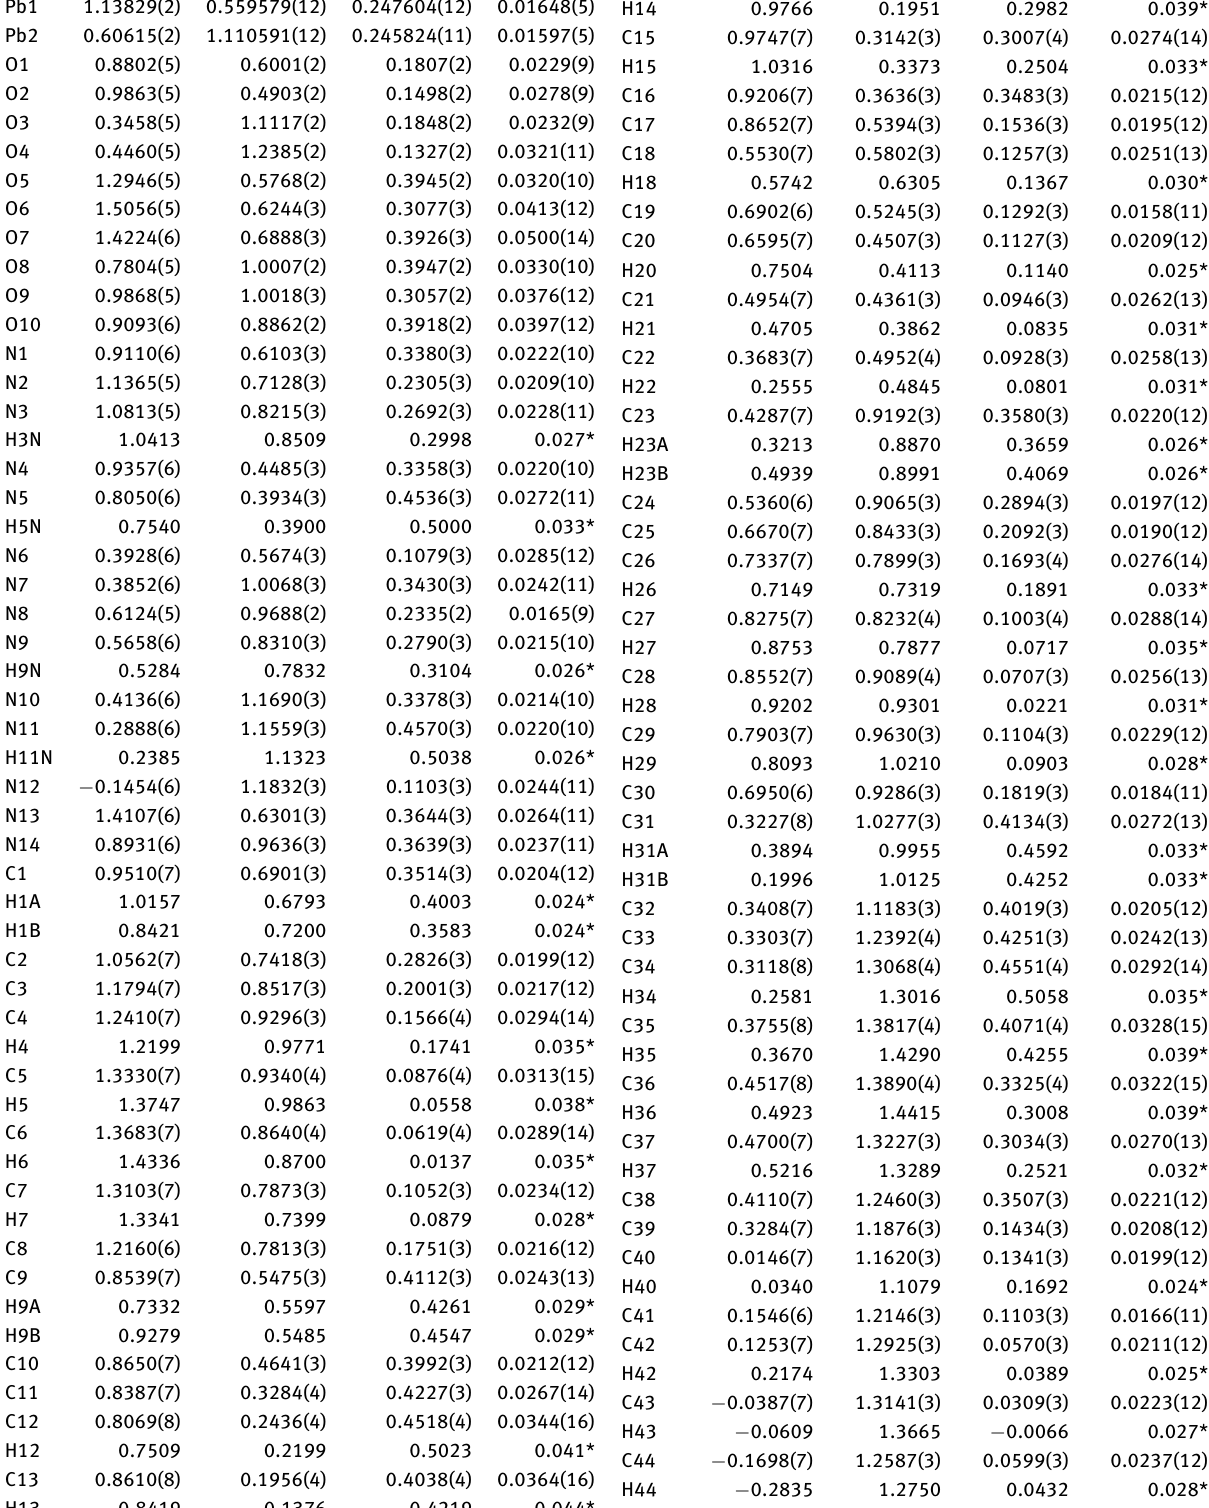
Table 2: Fractional atomic coordinates and isotropic or equivalent isotropic displacement parameters (Å 2